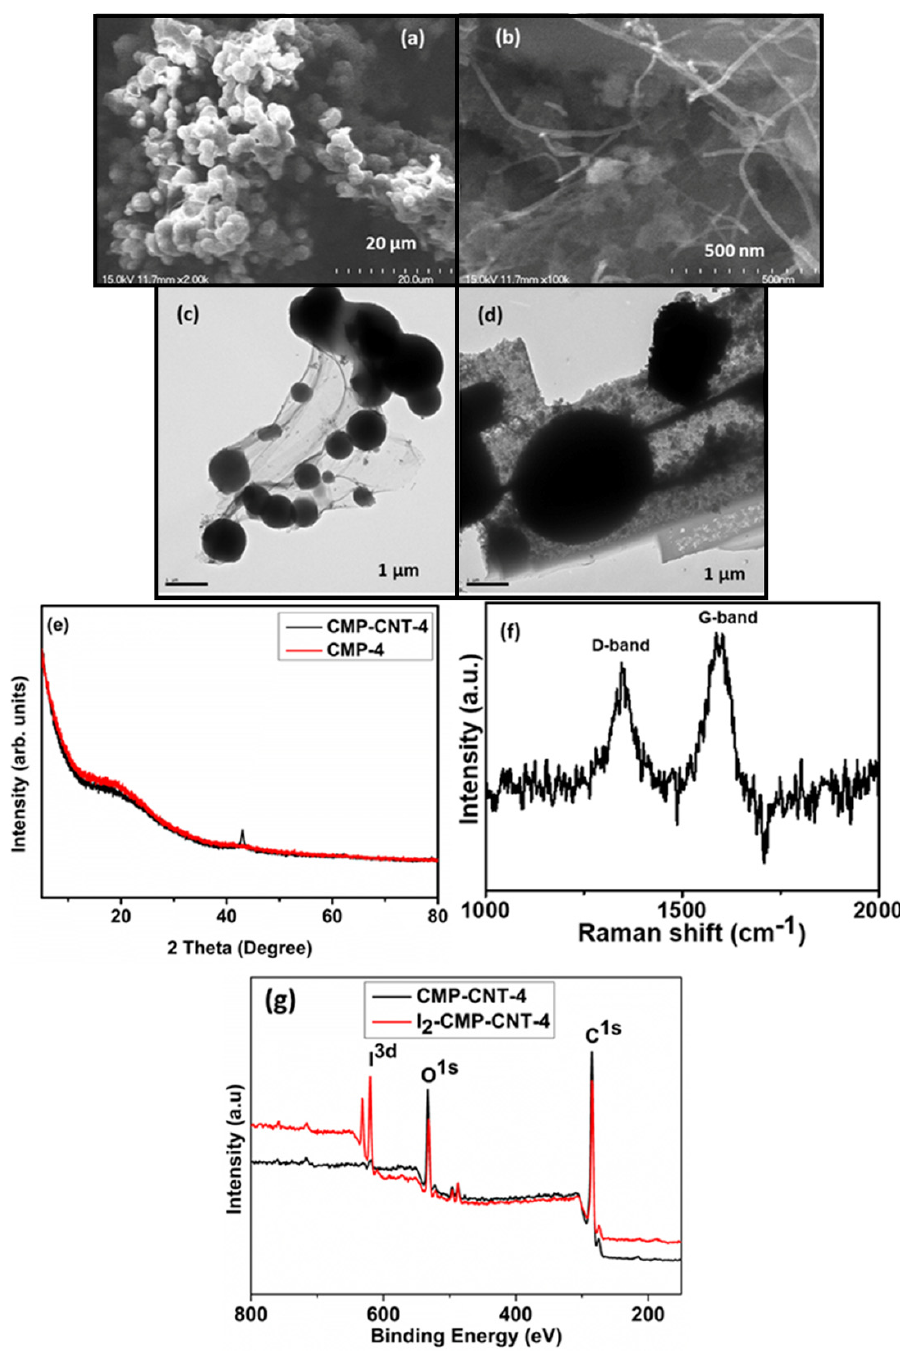
Figure 2. ( a ) SEM image of CMP ‐ 4, ( b ) SEM image of CMP ‐ CNT ‐ 4, ( c ) TEM images of CMP ‐ 4 ( d ) TEM image of CMP ‐ CNT ‐ 4, ( e ) XRD patterns of CMP ‐ 4 and CMP ‐ CNT ‐ 4, ( f ) Raman spectra of CMP ‐ CNT ‐ 4, ( g ) XPS spectra of CMP ‐ CNT ‐ 4 and I 2 ‐ CMP ‐ CNT ‐ 4.